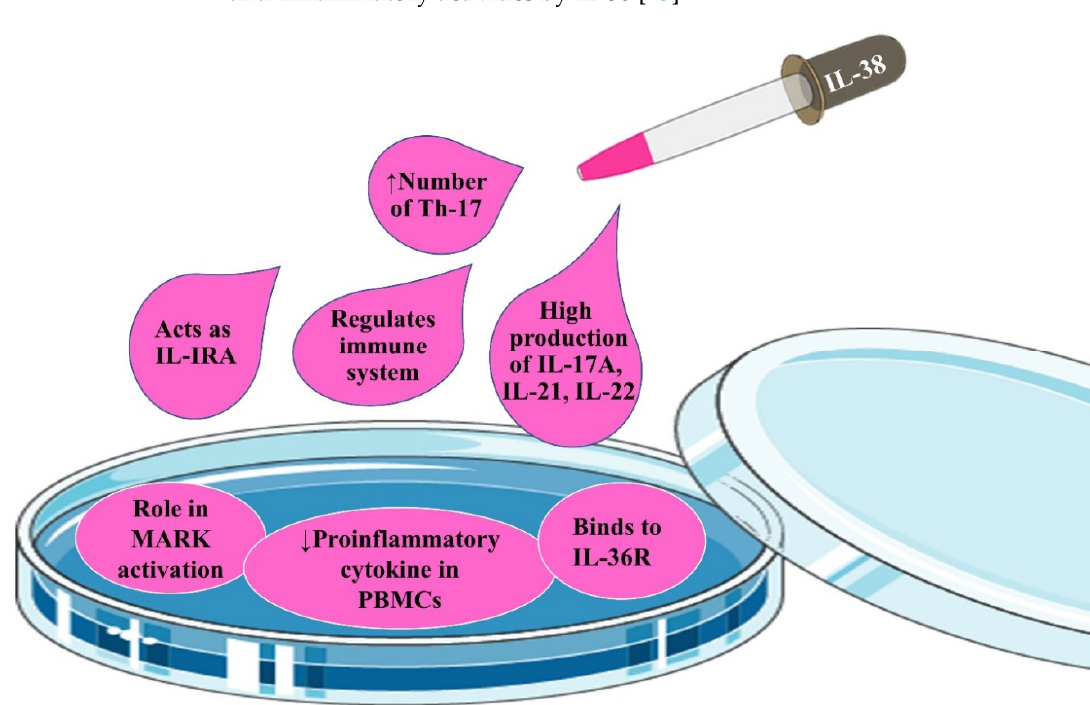
Figure 4. Immunobiological activities of IL-38 in host immune system. Created by Esmaeilzadeh et al. IL-38 acts as an antagonist for the pro-inflammatory properties of IL-36 in PBMCs and as an agonist for inflammatory responses in DCs.